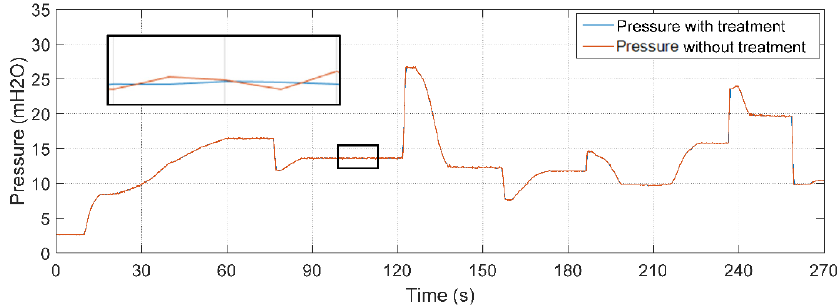
Figure 15. Pressure in PT ‐ 3 with and without data pre ‐ processing.